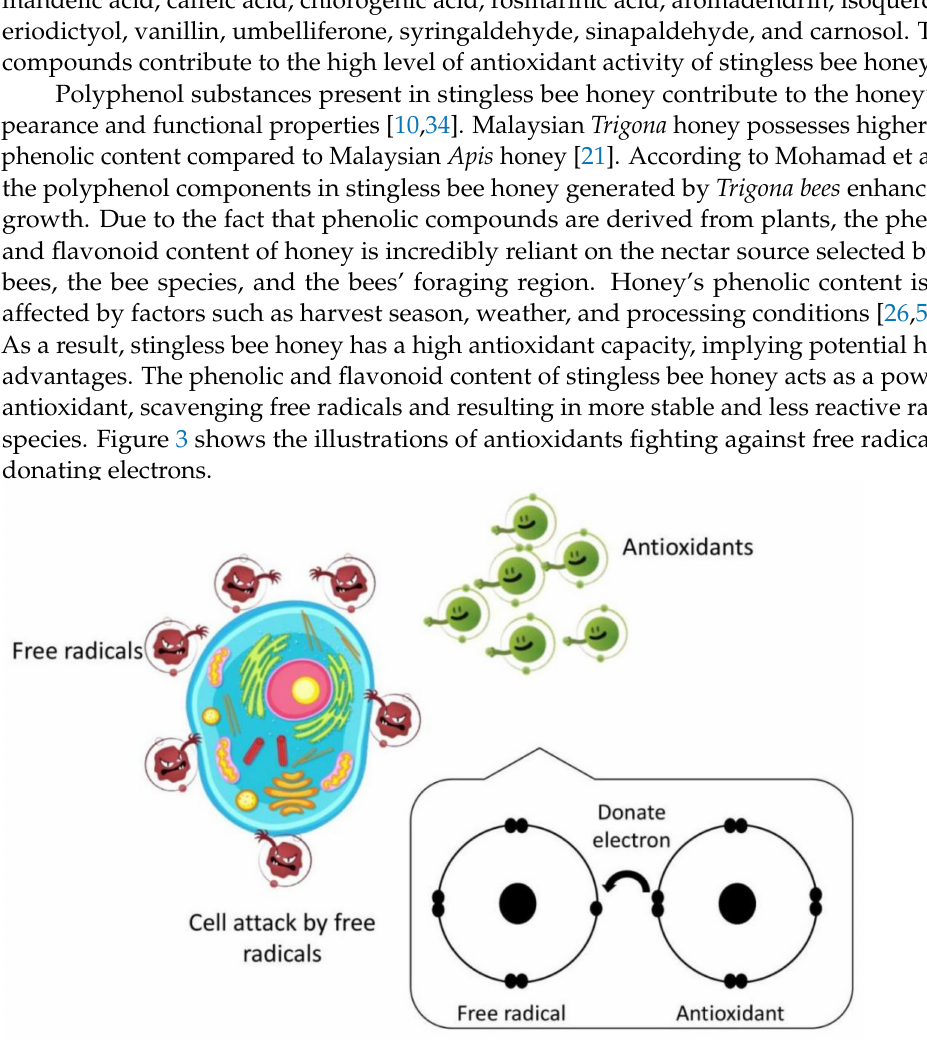
Figure 3. Illustrations of antioxidants fighting against free radicals by donating